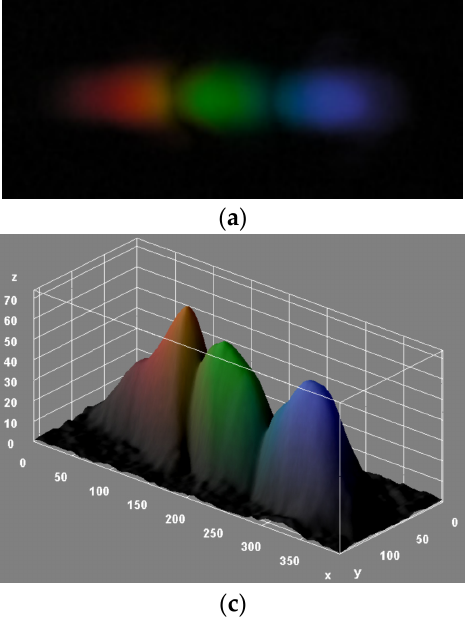
Figure 4. Reflected first diffraction order images from the DVD grating, recorded by the smartphone and background corrected with ImageJ, for ( a ) air and ( b ) water samples. Three-dimensional surface RGB intensity value plots of ( a , b ) are shown in ( c , d ), respectively. x-axis and y-axis units are pixels, and z-axis is scaled in pixel intensity units (ranging from 0 to 255).